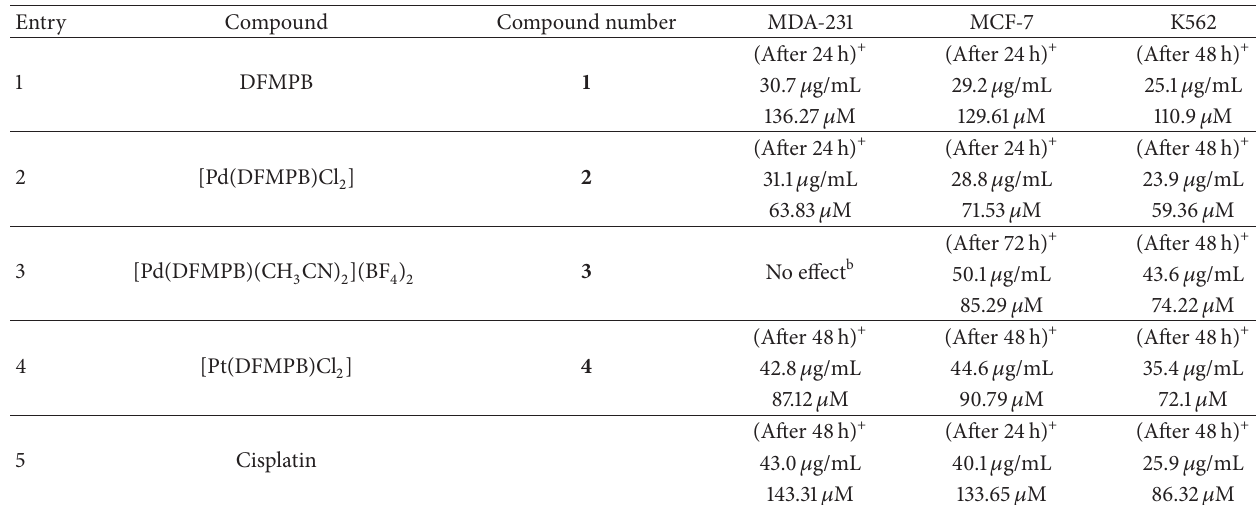
Table 2: MTT (3-(4,5-dimethylthiazol-2-yl)-2,5-diphenyltetrazolium bromide) results, the values shown are IC 50 a